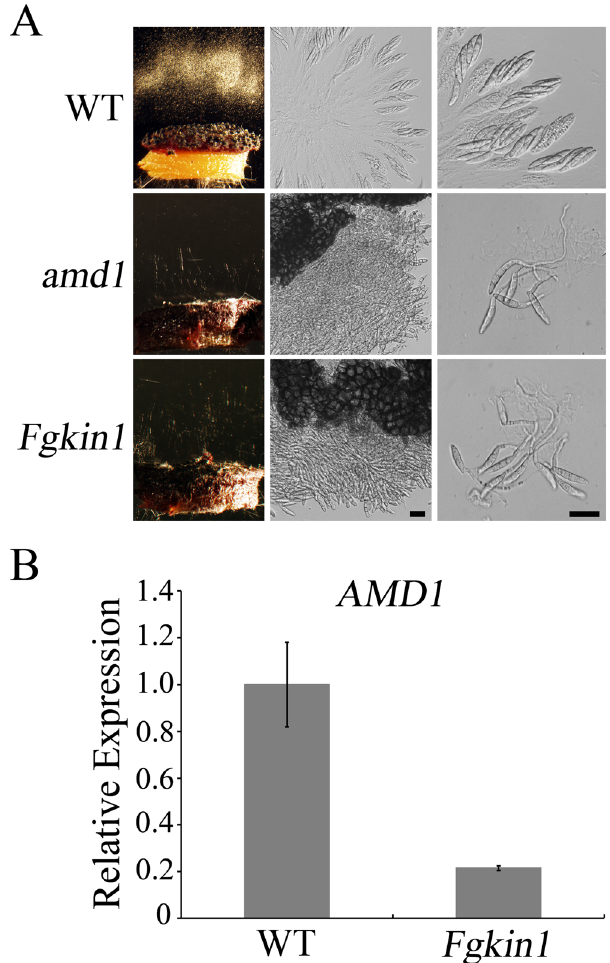
germination inside perithecia. Bar = 20 μ m. ( B) The expression level of AMD1 was assayed by qRT-PCR with RNA isolated from 7 dpf perithecia of the wild-type PH-1 and Fgkin1 mutant. The expression level of AMD1 in PH-1 was arbitrarily set to 1. Mean and standard deviation were calculated with data from three independent